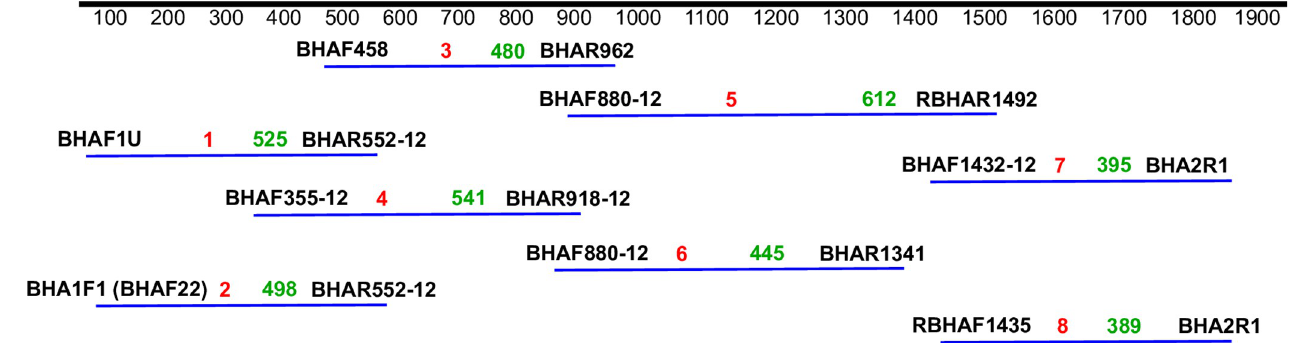
Fig 1. A schematic of primer locations on the influenza B HA gene. A schematic representation of the influenza B HA gene showing overlapping fragments and their expected sizes in base pairs. All sixteen primers and their corresponding eight fragments are shown. Red and green colors indicate fragment numbers and expected sizes,